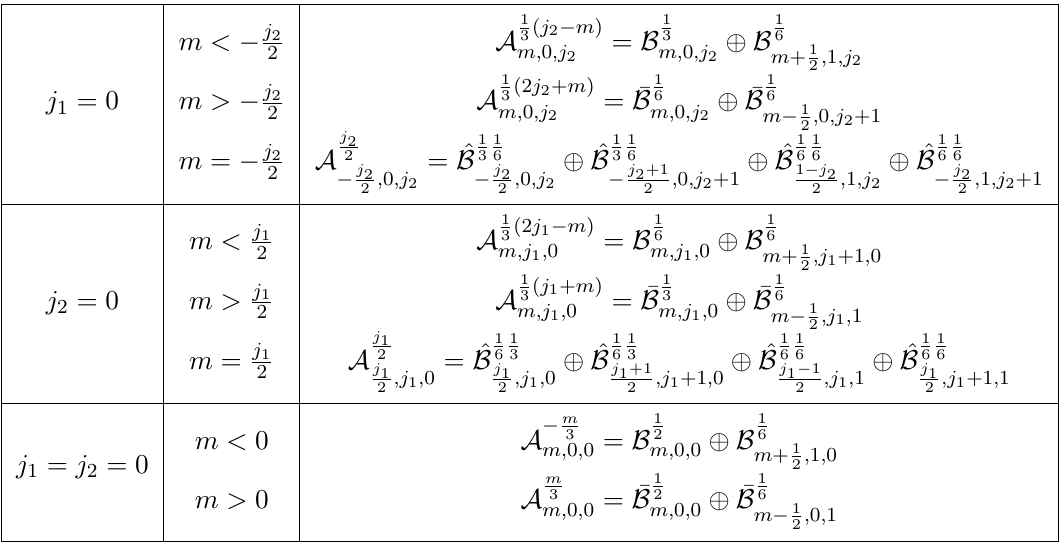
Table 1 . Decomposition of long multiplets into short ones for the case of some vanishing Dynkin